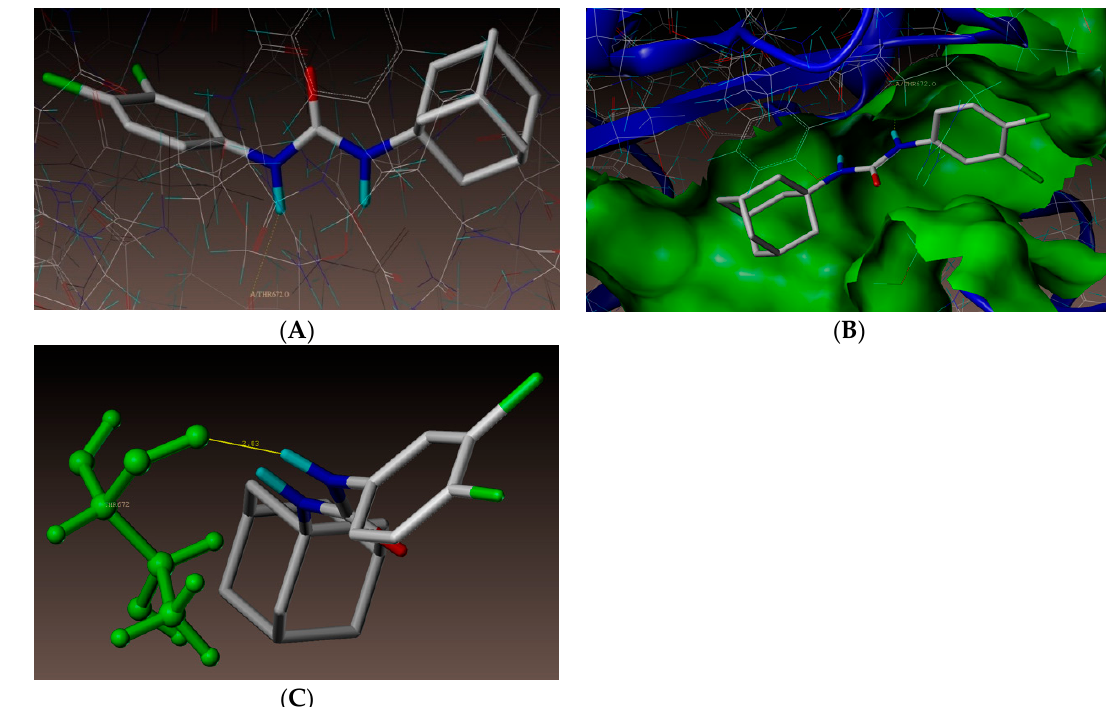
Figure 7. ( A ) Docked view of compound 3l . ( B ) Docked view of compound 3l at the active site of enzyme PDB ID: 3UDI. ( C ) Hydrogen-bond interaction of compound 3l at the active site. Antibiotics 2019 , 8 , x